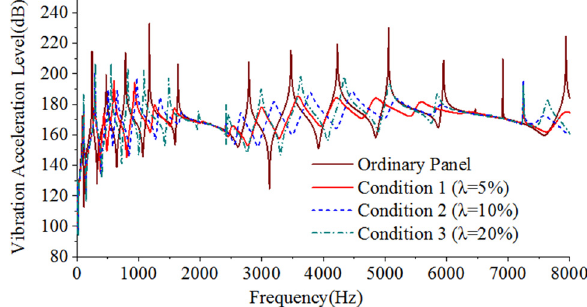
Figure 4: Vibration transfer function of the assessment point under various conditions.